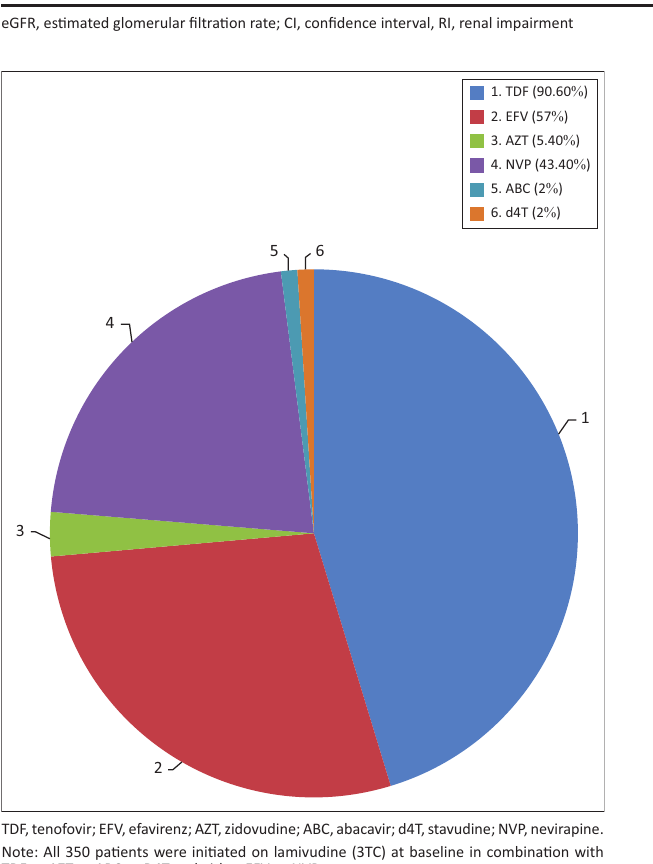
FIGURE 3: Distribution of antiretroviral treatment at treatment initiation.